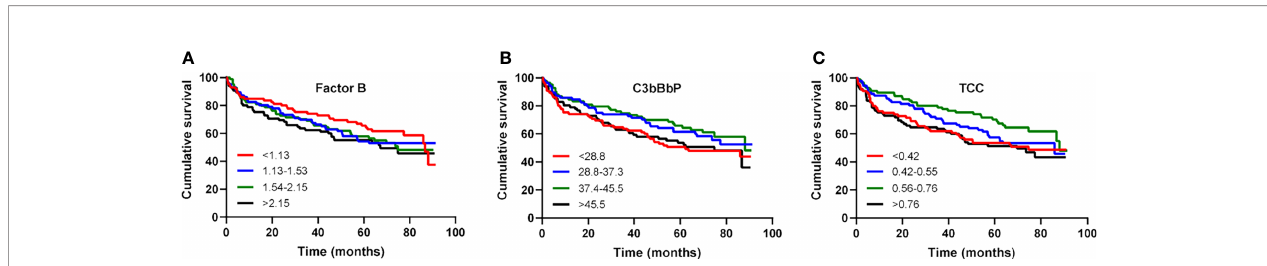
FIGURE 3 | Factor B, C3bBbP and TCC levels are not associated with all-cause mortality in patients with heart failure. Kaplan – Meier survival analysis of cumulative survival in relation to quartile levels of (A) factor B, (B) C3bBbP and (C) TCC.